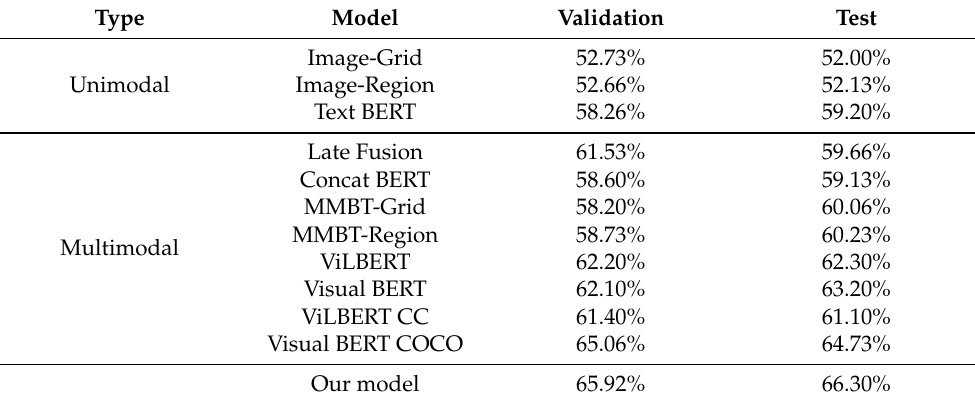
Table 1. The prediction accuracy of different models on the “Hateful Memes Challenge” data set.